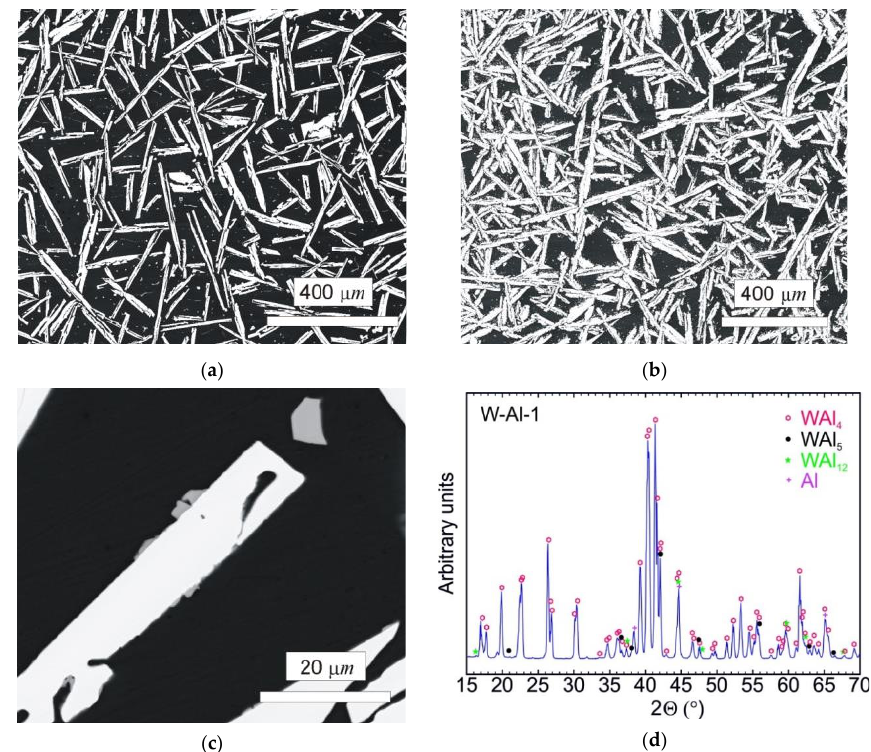
Figure 5. ( a ) SEM-BSE image of the bottom part of the W – Al-VIM-1 alloy; ( b ) SEM-BSE image of the upper part of the W – Al-VIM-1 alloy; ( c ) SEM-BSE image of WAl 12 phase in the bottom part of the W – Al-VIM-1 alloy; ( d ) diffraction pattern of sample W – Al-VIM-1.